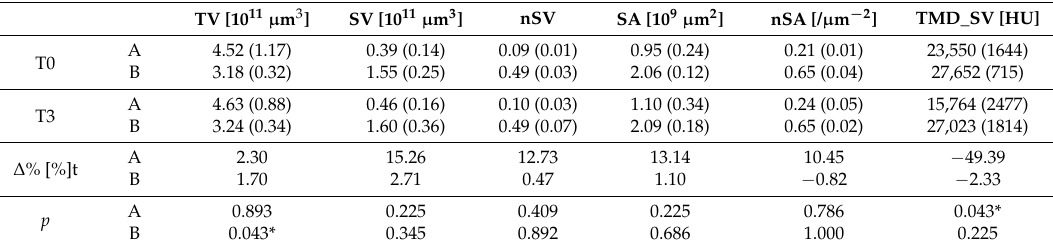
Table 2. Data showing the µ CT characteristics of the analyzed scaffolds (groups A and B) comparing changes during the total incubation time (T0 vs. T3). Mean values with standard deviation of the mean in brackets. ∆ % = 1 − (T0/T3) represents the percentage difference comparing two time points: ∆ % [%]t = T0 vs. T3. p shows the p -values comparing T0 with T3. Significant differences are distinguished by